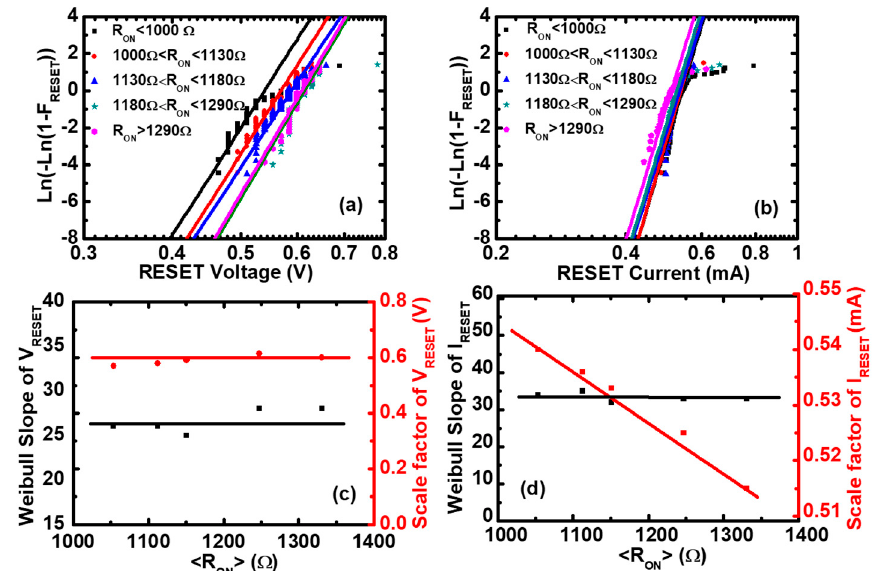
Figure 3. The Weibull distributions of the Reset voltage and the Reset current in Pt / Pt:SiO x / Ta devices. Experimental distributions (symbols) and the fitting to Weibull distribution (lines) of ( a ) the Reset voltage and ( b ) the Reset current as functions of the ON-state resistance. Weibull slopes and scale factors of ( c ) the Reset voltage and ( d ) the Reset current versus < R ON > , where < R ON > is the average value of the ON-state resistance ( R ON ) in each screening range. It can be seen that the Weibull slopes of the Reset voltage and the Reset current are independent of < R ON > , and the scale factor of the Reset voltage is constant, whereas the Reset current is inversely proportional to < R ON > .